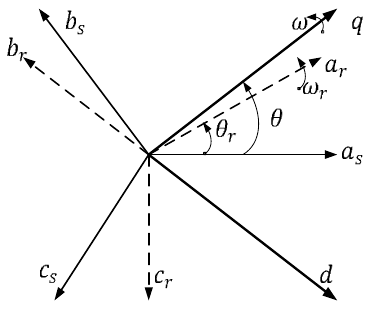
Figure 5 . Two axis reference frames for DFIG. Figure 5. Two axis reference frames for